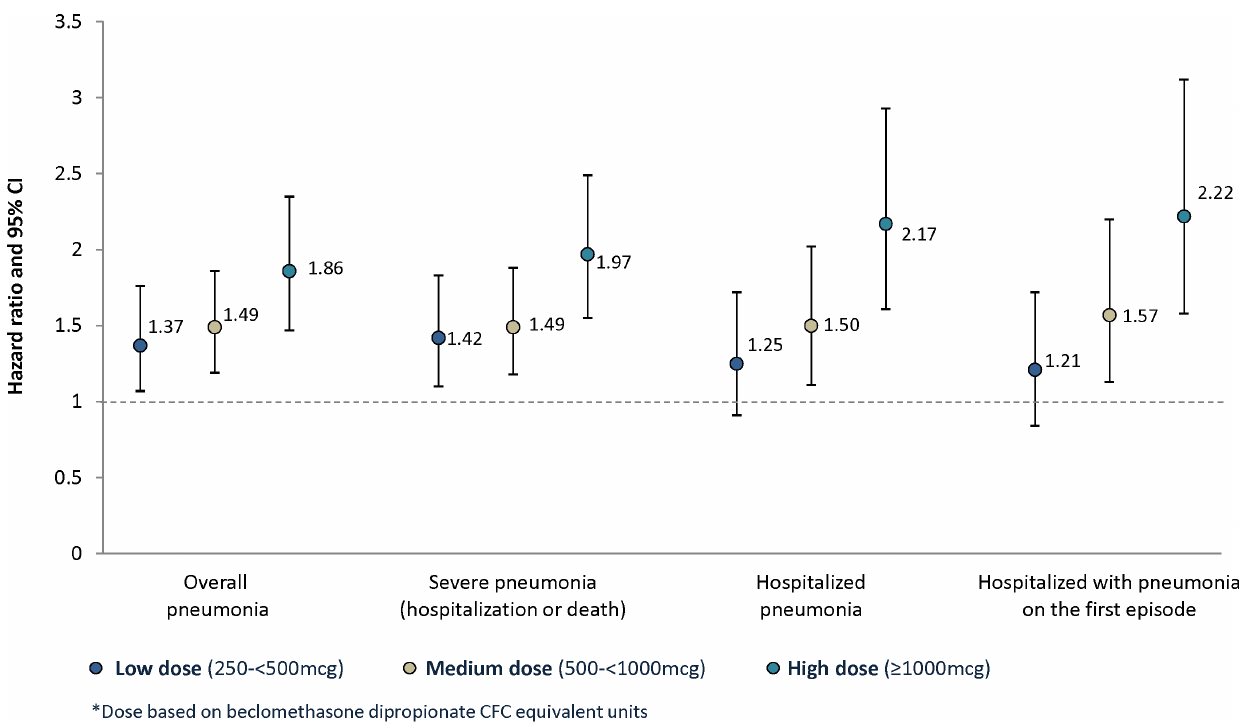
Figure 3. Pneumonia by different definitions and ICS daily dose in new users of ICS-containing medications. Data are hazard ratios and 95% CI for ICS compared with LABD. CFC: chlorofluorocarbon; ICS: inhaled corticosteroid; LABD: long-acting